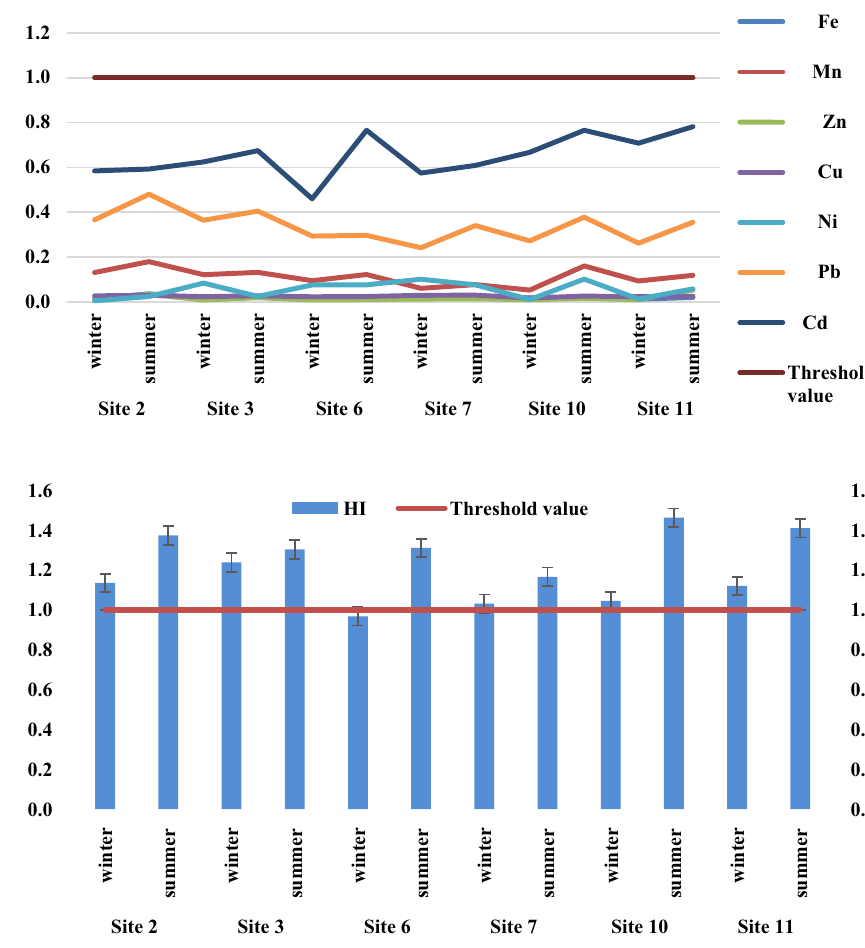
Fig. 6 Target hazard